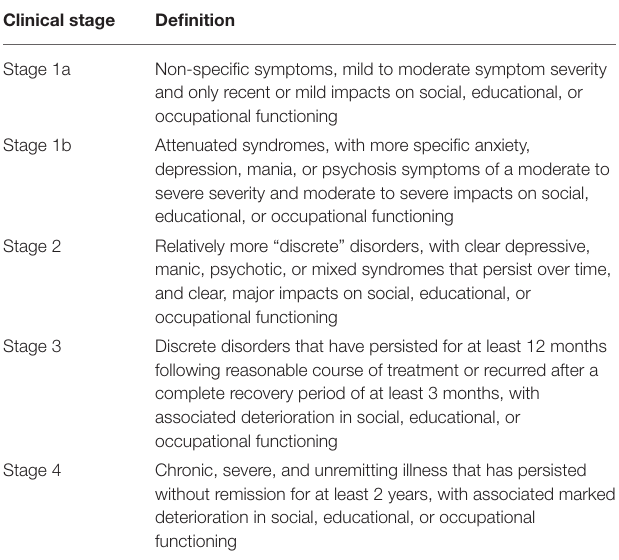
TABLE 1 | Clinical stages for youth mental health